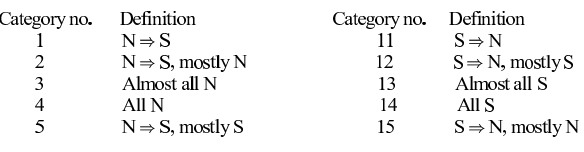
Table 3. Magnetic Cloud 2 B (or B z )